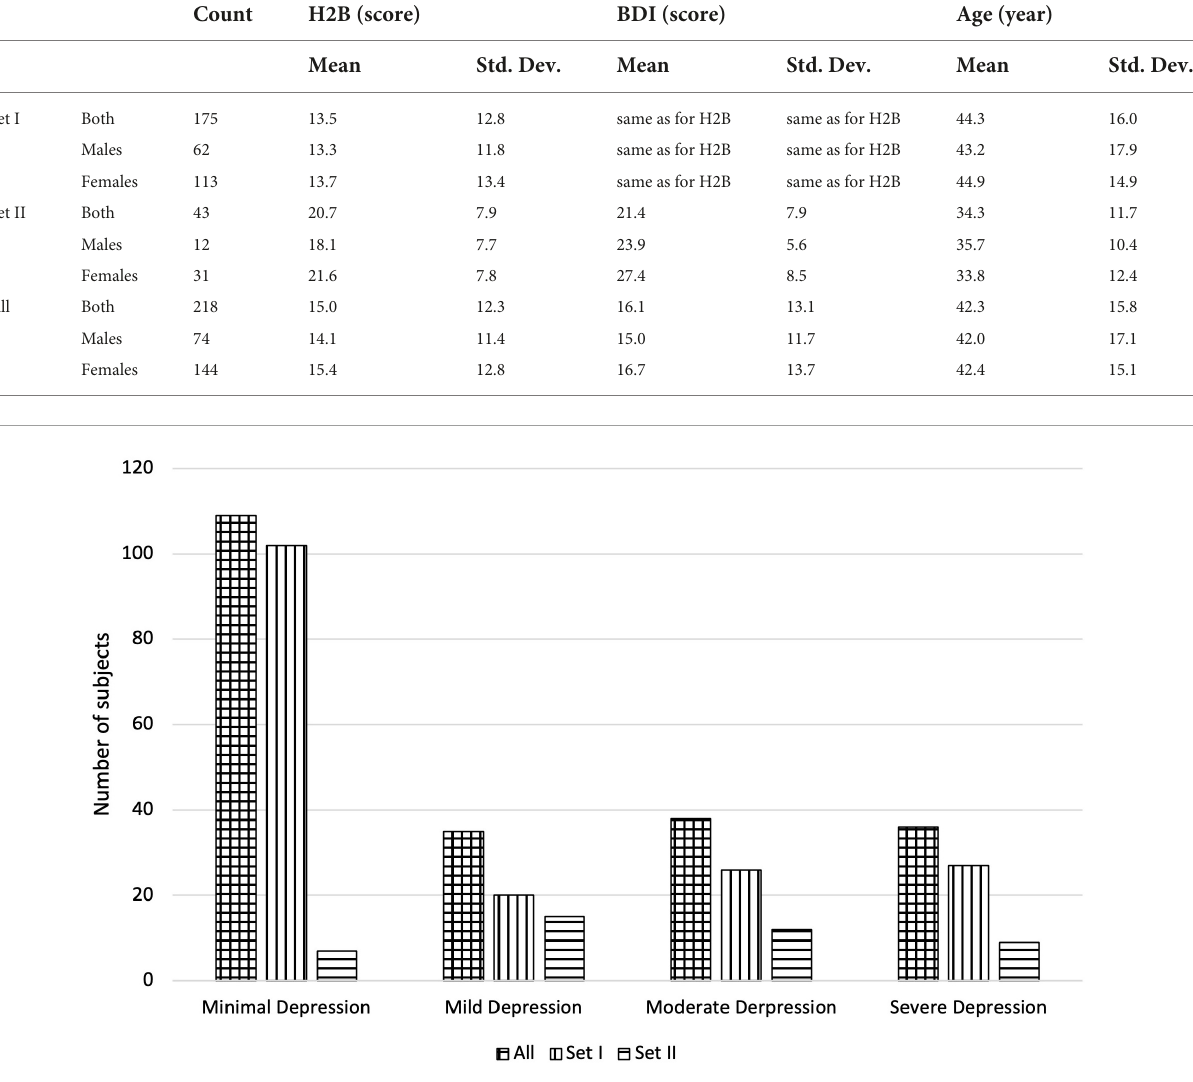
TABLE 1 Main descriptive statistics of subjects of the applied Depressed Speech Database (DEPISDA).